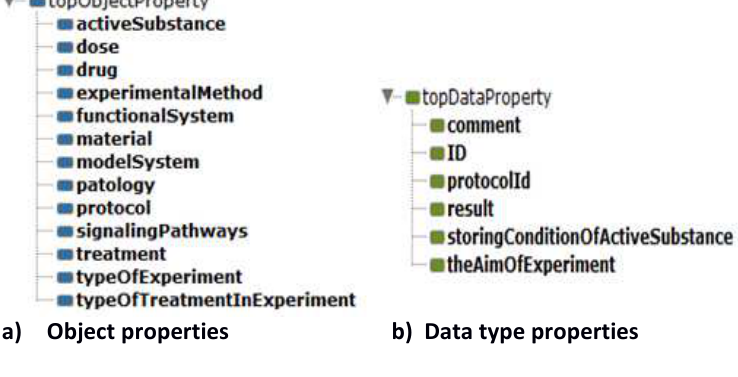
Figure 3. PIBAS ontology properties.